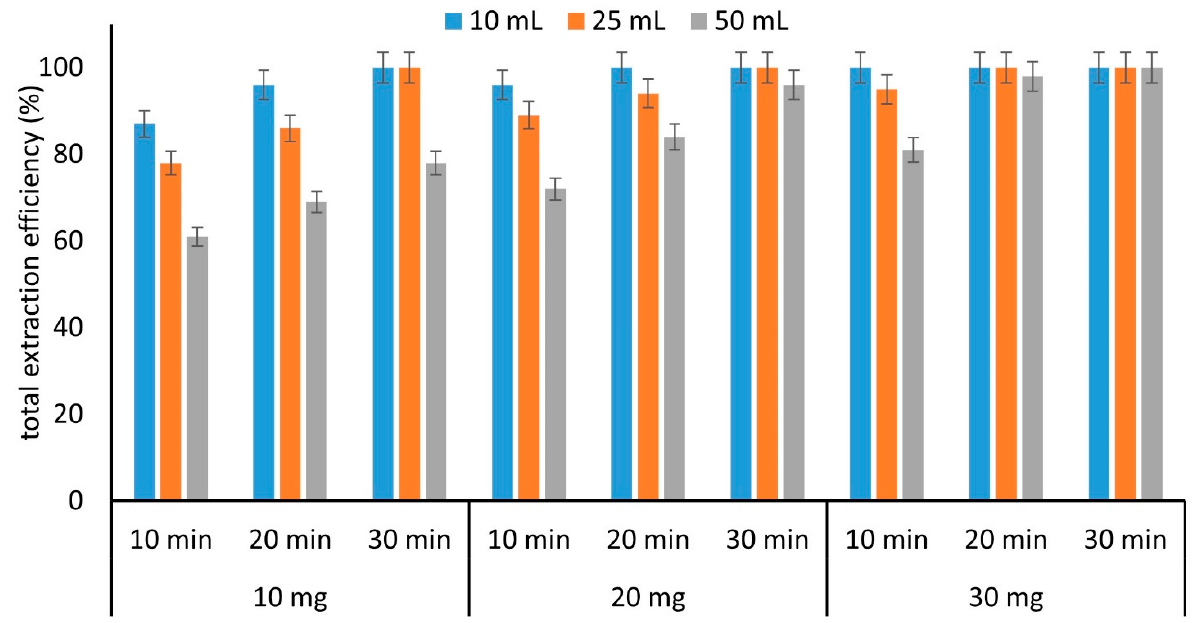
Figure 7. Total extraction efficiency of the examined compounds with respect to sample volume, amount of sorbent (GQDs-LDH), and extraction time (number of replicate analyses =